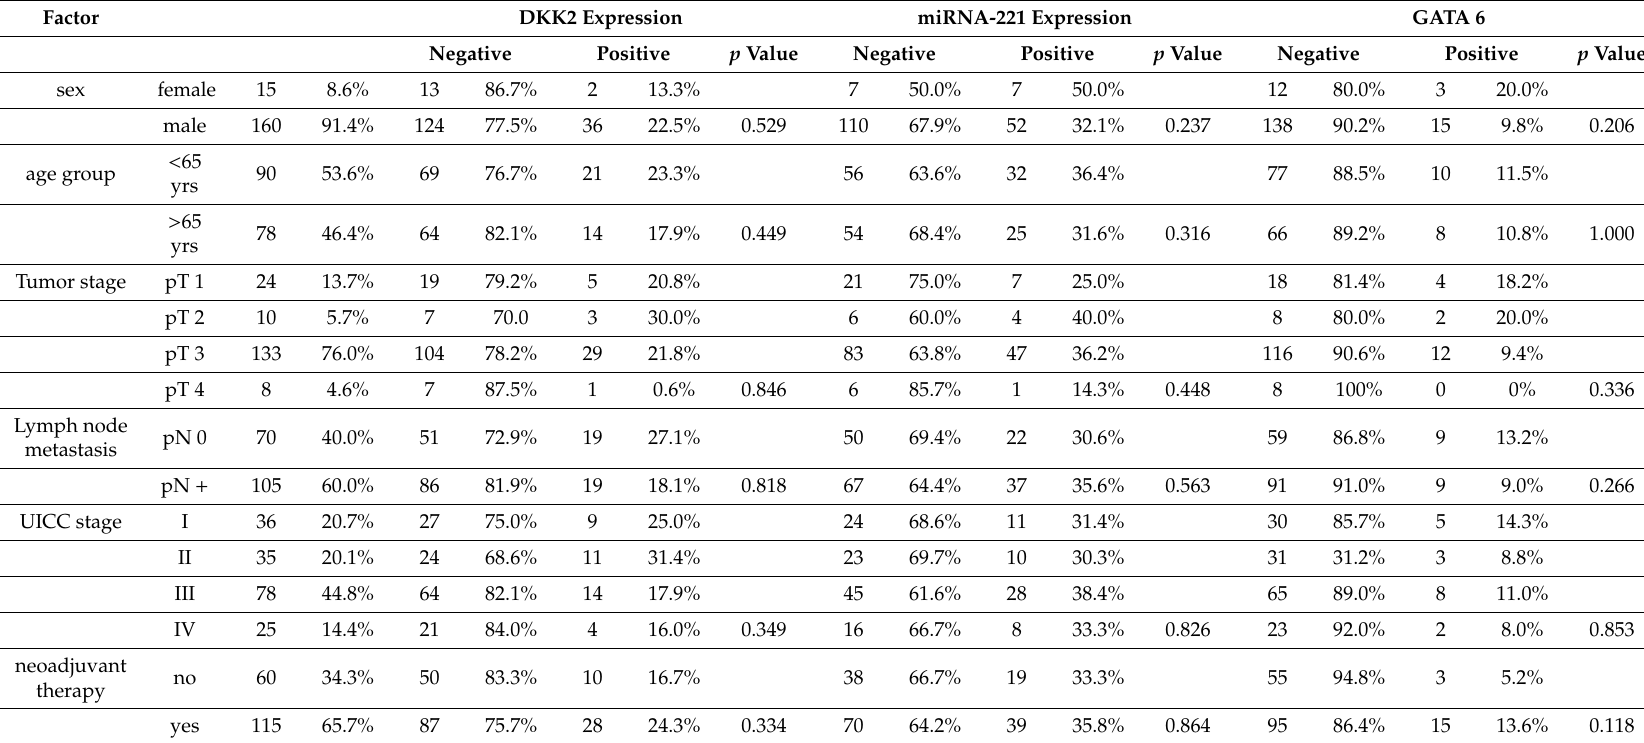
Table 1. Clinico-pathological parameters for the entire patients´